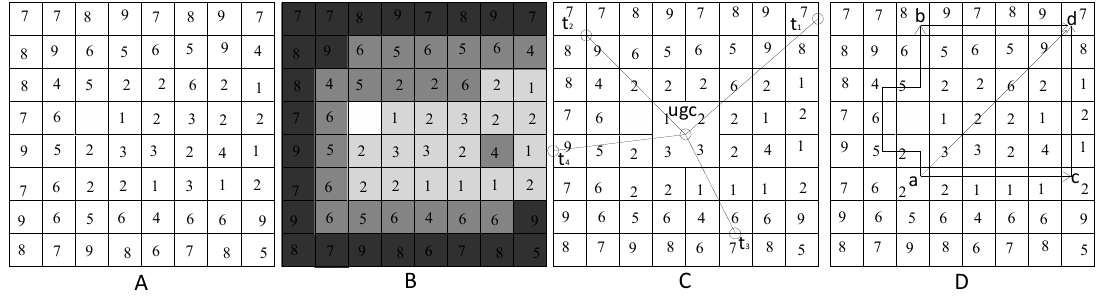
Figure 7. The digital grid consists of the basic cell representing the LMCR value, and the cell with no data denotes the ecological barrier. The four digital grids ( A , B , C , and D ) represent the LMCR surface, suitability zone, the resistance variation in different directions and the calculation of expansion paths, respectively. Moreover, the urban geographic center (UGC) denotes the urban geographic center and 𝒕 indicates the satellite town.